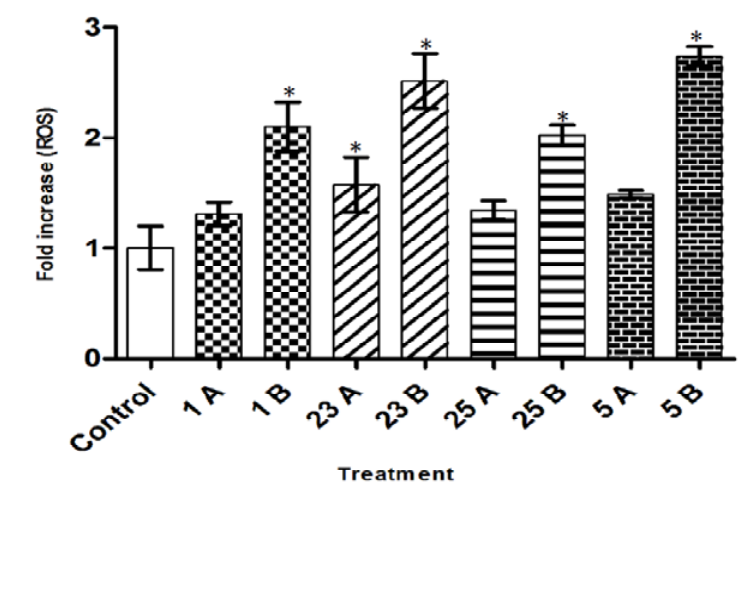
Figure 5. Fold increase of reactive oxygen species (ROS) in MCF-7 cells after treatment with compounds 1 , 23 , 25 , and 5 compared to control (untreated MCF-7 cells). (1A- 3 µg/mL; 1B- 6 µg/mL), (23A- 3 µg/mL; 23B- 6 µg/mL), (25A- 2 µg/mL; 25B- 4 µg/mL) and (5A- 3 µg/mL; 5B- 6 µg/mL). Triplicates of each treatment group were used in